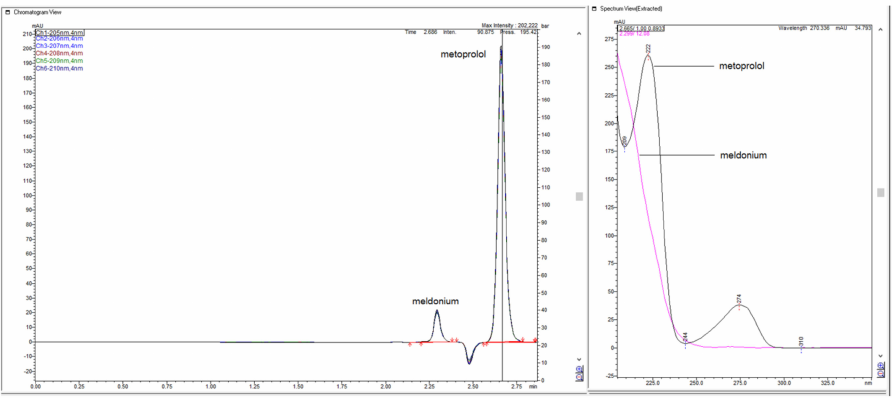
Figure 45. Chromatograms with application of percentage of ACN with 60%, showed a very slight increased retention for both analytes with very good shaped peaks, but with disappearing small peaks and appearing negative peaks between meldonium and metoprolol, with column Zorbax CN-SB 250 × 4.6